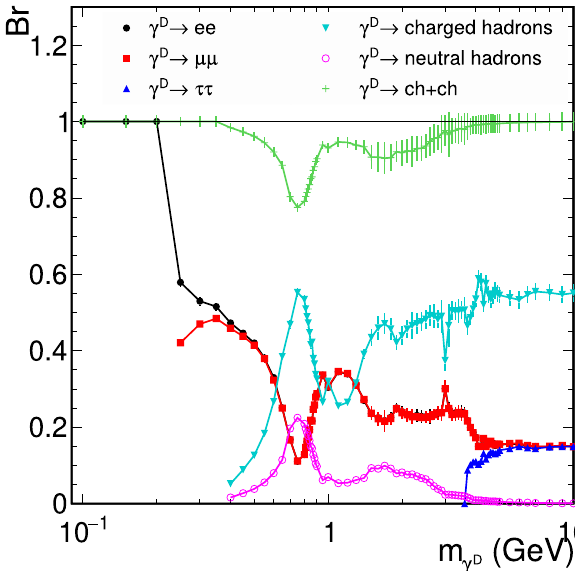
Fig. 8 Expected lifetime of the dark photon as a function of its mass and of the kinetic mixing parameter ε lifetime c τ :